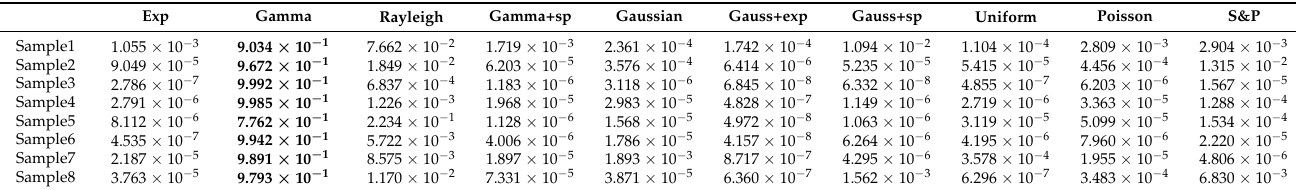
Table 1. Prediction results for the types of noise.